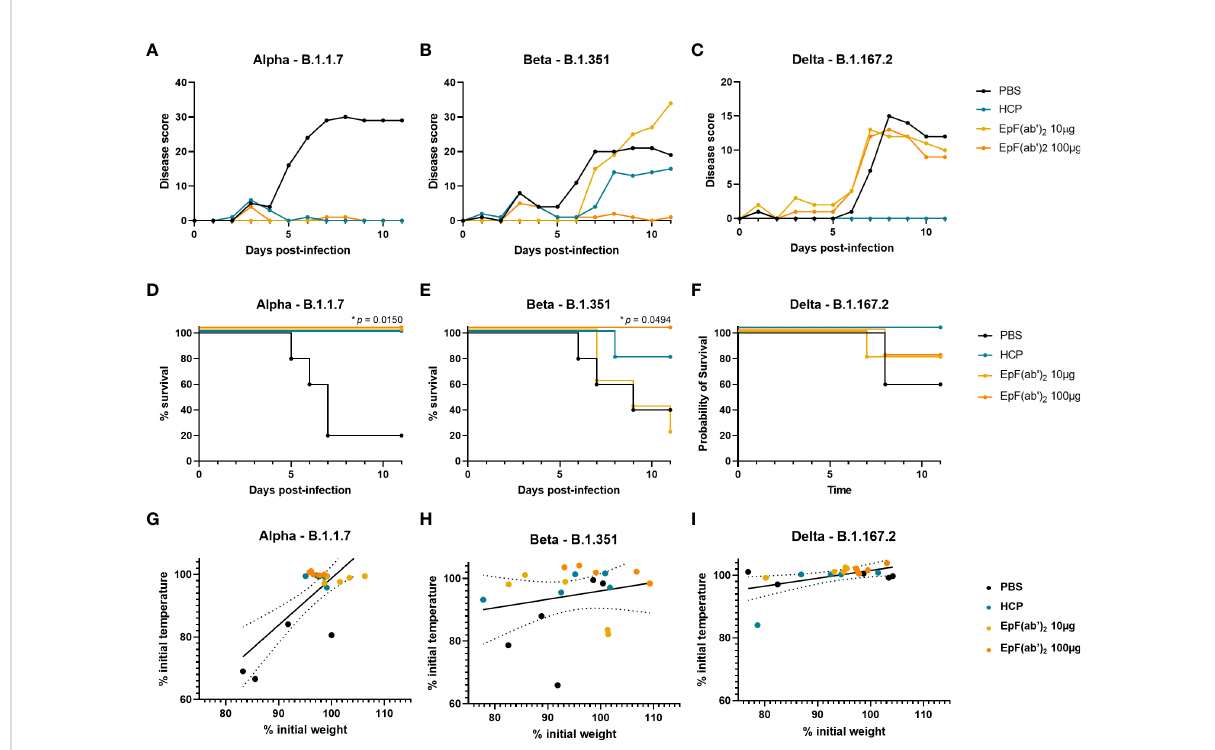
FIGURE 3 Treatment with EpF(ab ’ ) 2 helps reduce disease scores and improves survival in K18-hACE2 challenged mice. Cumulative disease scores of K18- hACE2 mice infected with Alpha (A) , Beta (B) , and Delta (C) over time. Kaplan Meyer representation of the percentage of survival over time of mice infected with Alpha (D) , Beta (E) , and Delta (F) . Correlations between weight loss, represented as percentage of weight at day 0, and temperature loss, represented as percentage of temperature at day 0 of K18-hACE2 mice infected with Alpha (G) , Beta (H) , and Delta (I)